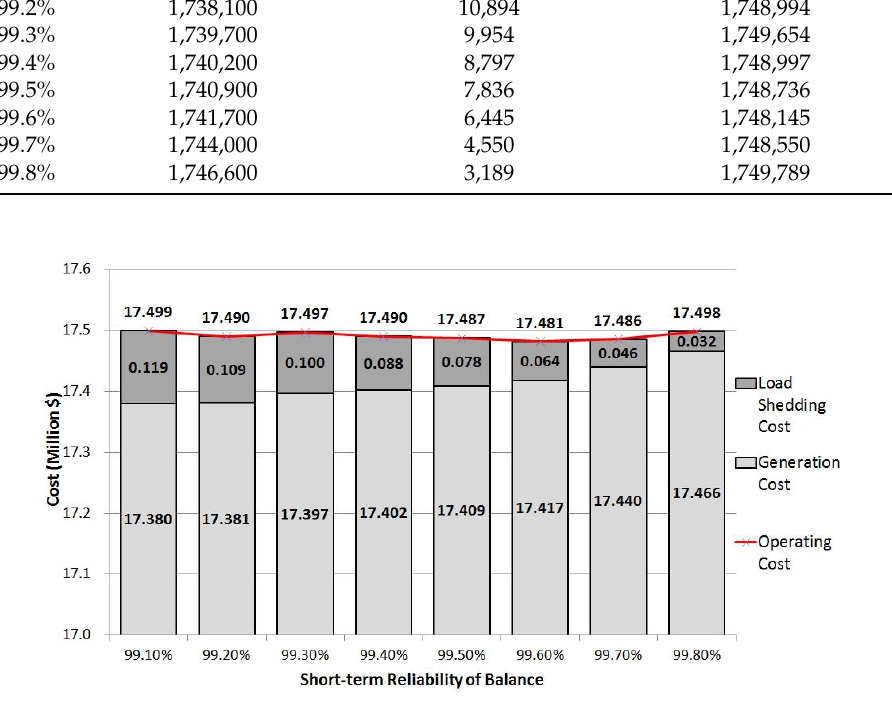
Figure 4. The generation costs and the cost for interruption as a function of the short-term reliability of balance.